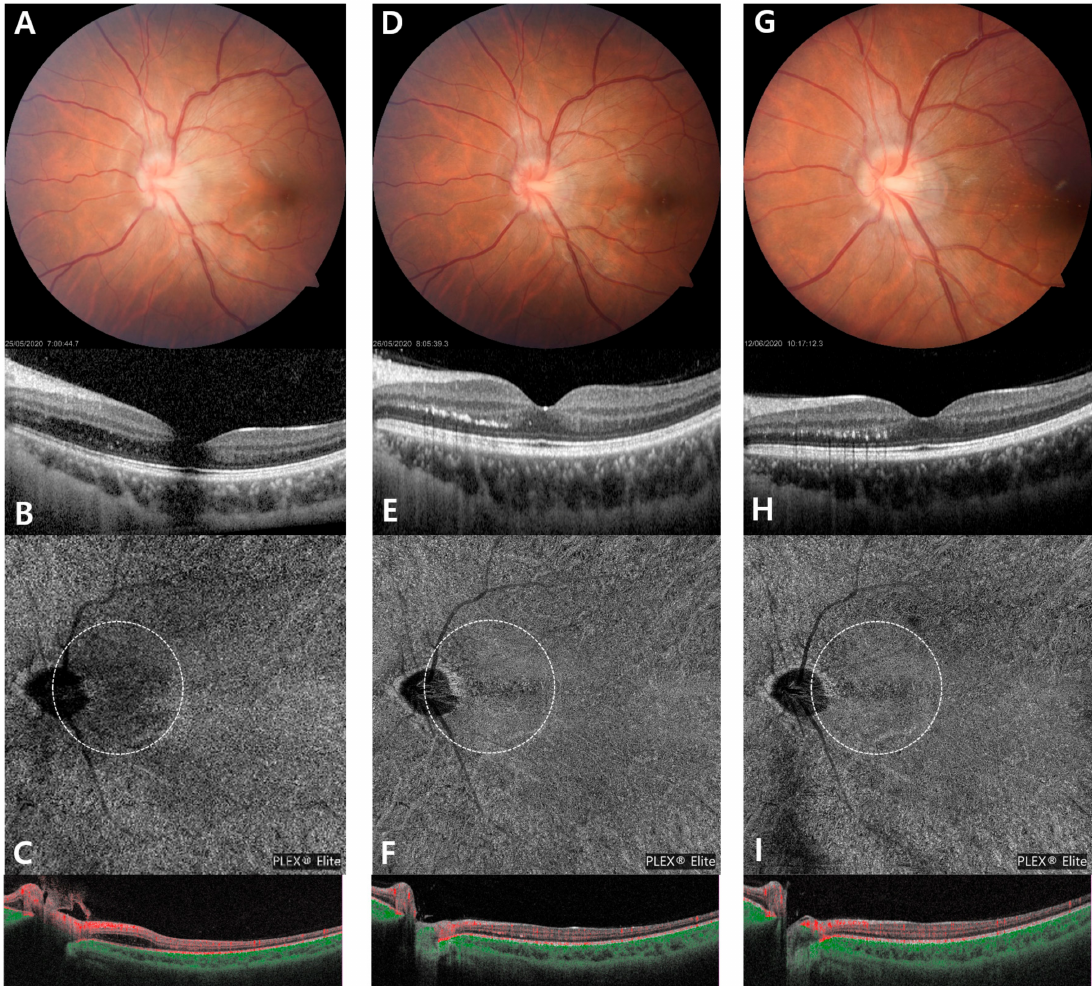
Figure 2. Follow-up multi-modal images at two days after the initial examination ( A – C ), two days following steroid pulse therapy ( D – F ), and one month after treatment ( G – I ). On the serial color fundus photograph, mild optic disc edema was resolved, but linearly deposited hard exudates remained in the temporal peripapillary area ( A , D , G ). Although intraretinal edema was slightly aggravated at the second day of admission ( B ), it was completely resolved two days after the steroid pulse therapy ( E ). Localized choroidal thinning was also recovered, but hyperreflective spots linearly remained in the outer retina even one month after treatment ( H ). On the serial swept-source OCT angiography images, peripapillary flow deficits of the choriocapillaris increased on the second day of admission ( C ). After starting steroid pulse therapy, choriocapillaris flow deficits significantly reduced ( F ), which was maintained at the one-month follow-up